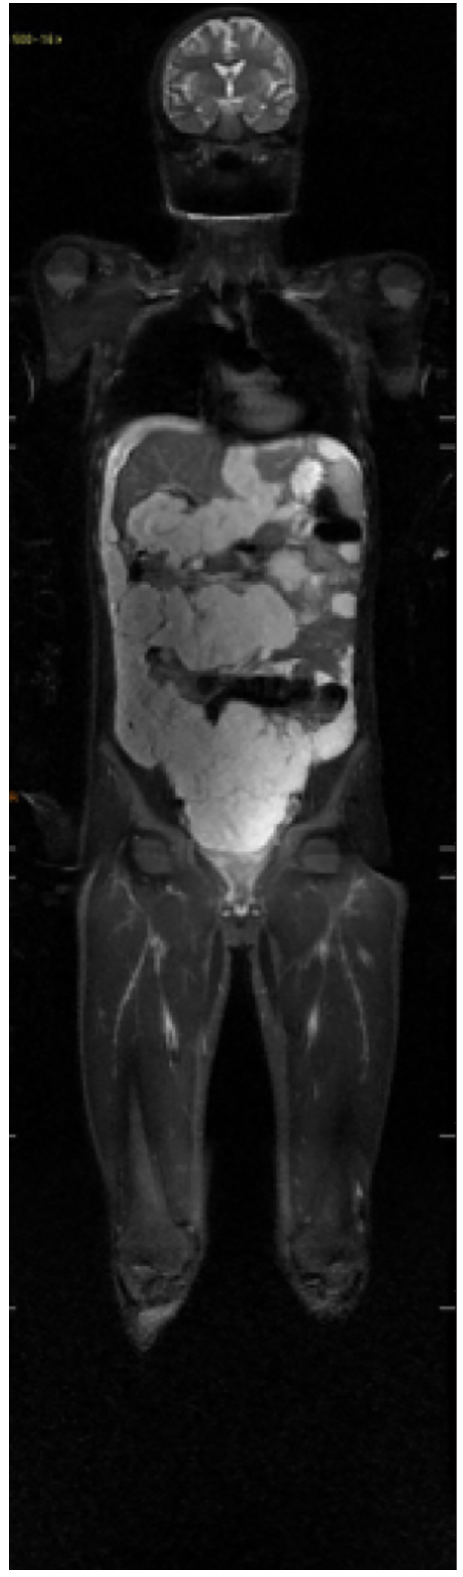
Fig 1. Coronal STIR sequence demonstrating multiple disseminated peritoneal lesions with high signal. No lesions were found at any other sites in this exam.